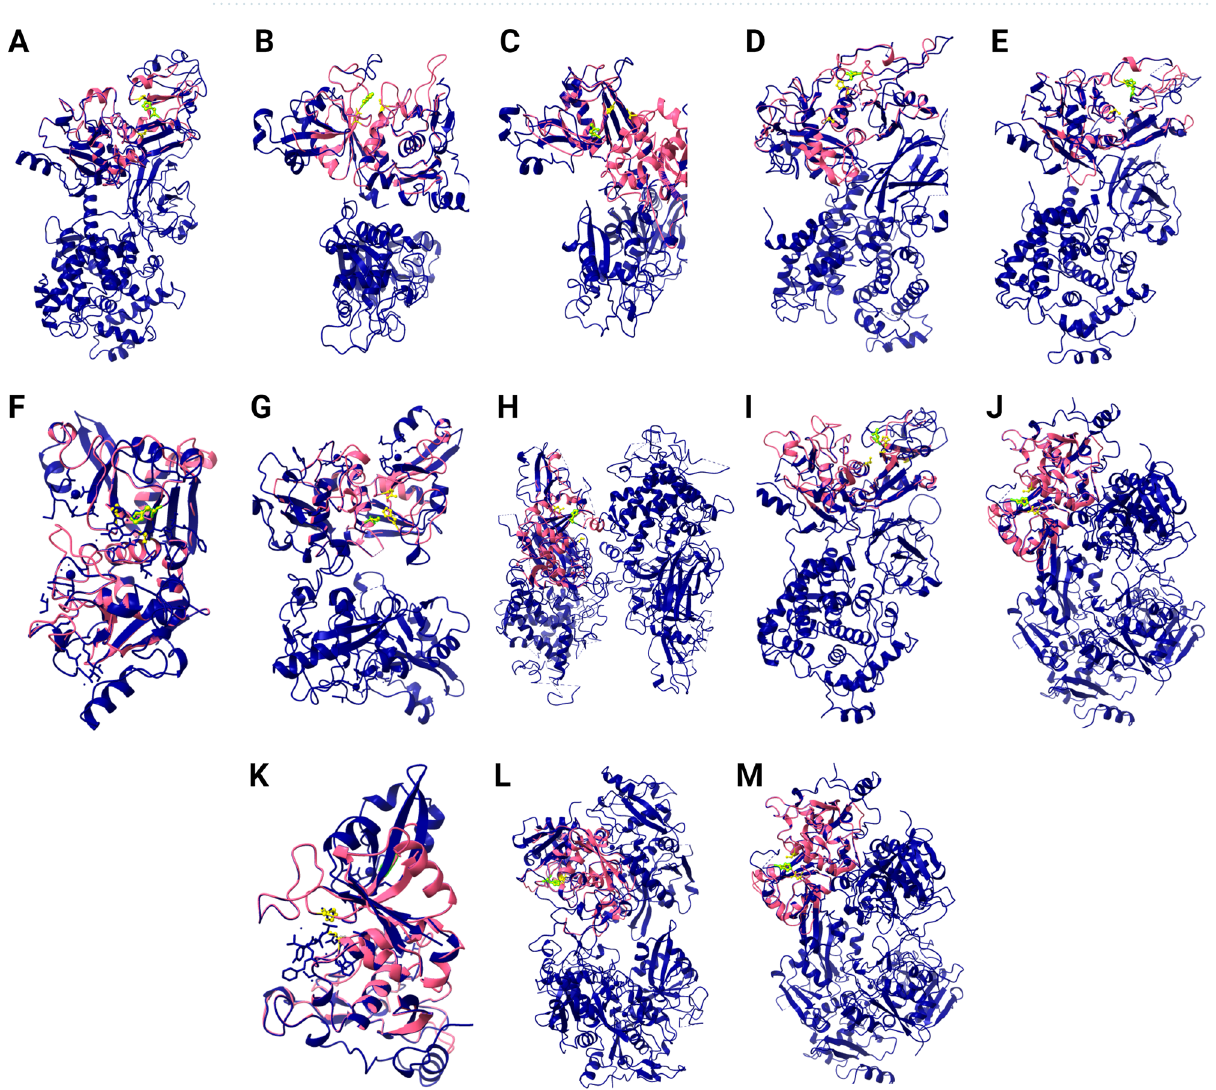
Figure 5. 3D structure modelling of cyanobacterial CysPC domains. The comparison of the template structure obtained from Protein Data Bank (dark blue) and the predicted 3D structure of the cyanobacterial CysPC domain (pink). Catalytic amino acid triad C, H, N is shown in yellow. ( A ) Anabaena minutissima , ( B ) Aphanizomenon flosaquae , ( C ) Calothrix parasitica , ( D ) Chamaesiphon minutus , ( E ) Chamaesiphon polymorphus , ( F ) Fischerella muscicola , ( G ) Fischerella thermalis 1, ( H ) Fischerella thermalis 2, ( I ) Microcystis aeruginosa , ( J ) Scytonema hofmannii 1, ( K ) Scytonema hofmannii 2, ( L ) Scytonema hofmannii 3, M) Trichormus variabilis